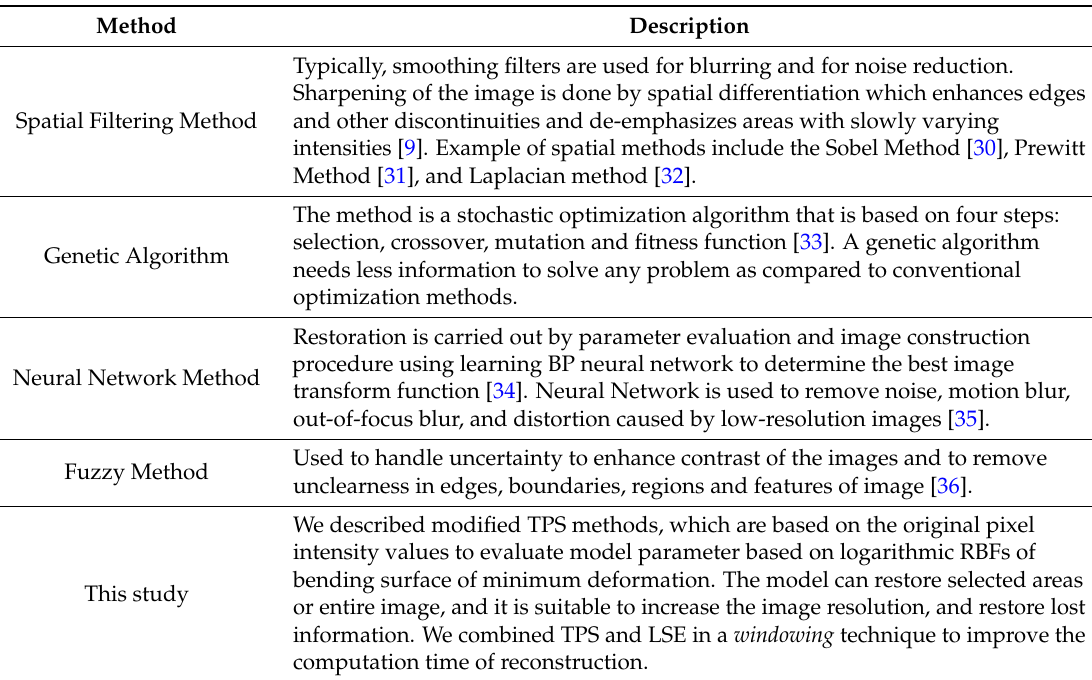
Table 5. Comparison with Fundamental methods used in image